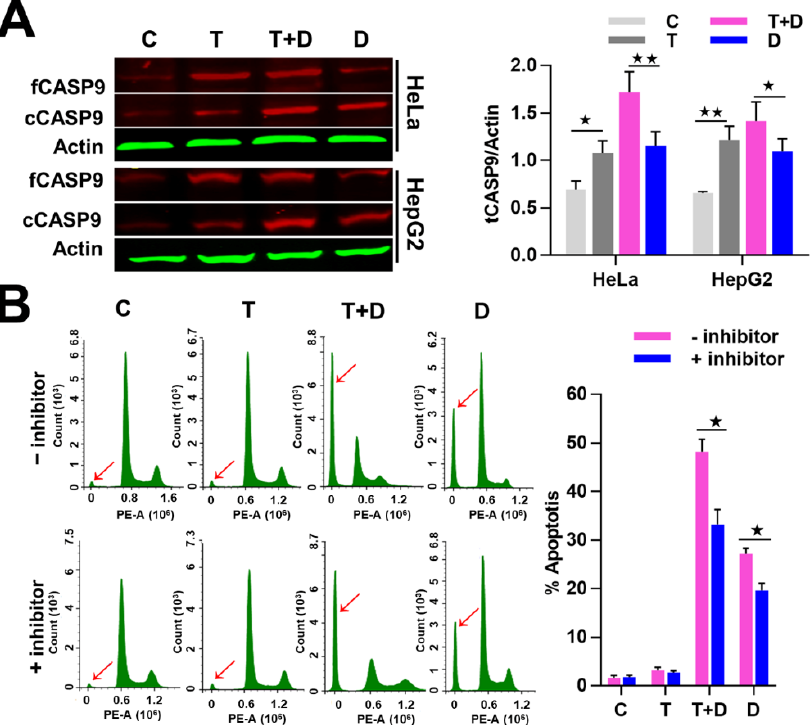
Figure 9. Contribution of NF- κ B-upregulated CASP9 to TNF α promotion of apoptosis induced by DOX. ( A ) Expression of CASP9 protein. The data are presented as the means ± SD from three independent experiments. fCASP9, cCASP9, tCASP9 and total CASP9; see Figure 4. The significance of the di ff erence was analyzed by one-way ANOVA. * p < 0.05; ** p < 0.01. ( B ) E ff ect of CASP9 inhibitor on cell apoptosis. Cells pretreated with 50 µ M CASP9 inhibitor for 30 min were treated with TNF α , DOX, or TNF α &DOX for 12 h. The sub-G1 peaks obtained from the FCM assay are labeled with red arrows. The data are presented as the means ± SD from three independent FCM detections. The significance of the di ff erence was analyzed by Student’s t-test. * p < 0.05; ** p < 0.01. C, T, T + D, D; see Figure 7.